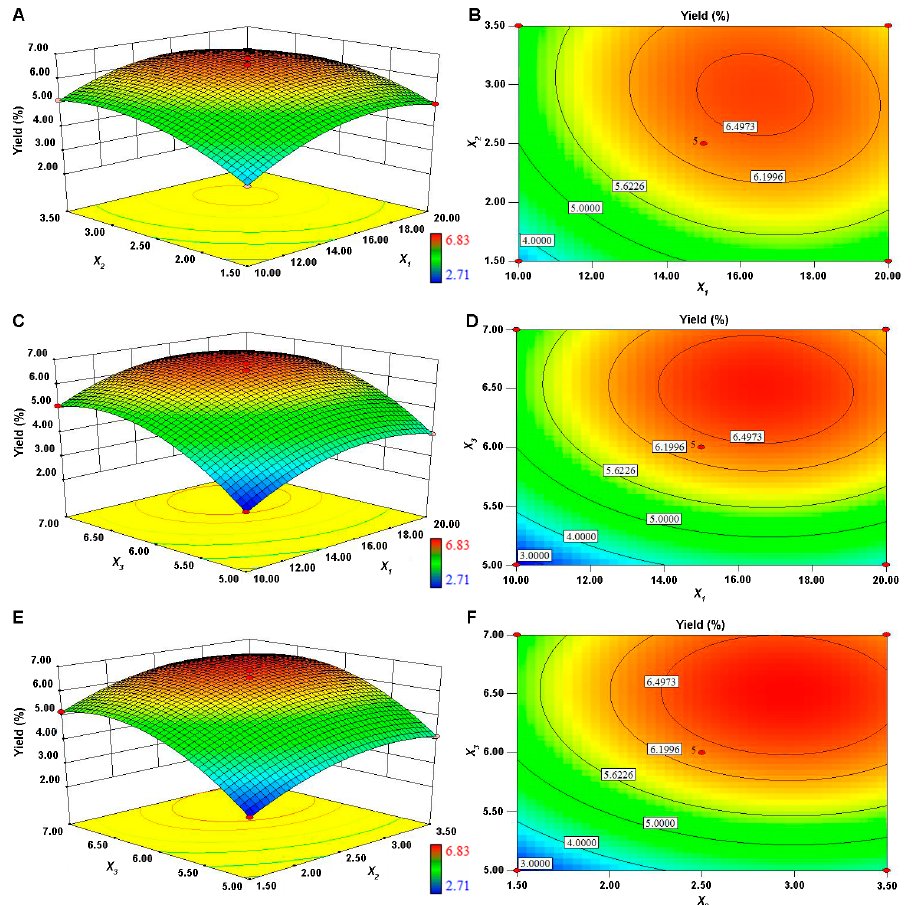
Figure 2. Response surface plots ( A , C and E ) and contour plots ( B , D and F ) showing the effects of variables ( X 1 , ratio of extraction solvent to raw material; X 2 , extraction time; X 3 , extraction pH) and their mutual effects on the extraction yield of PPP.